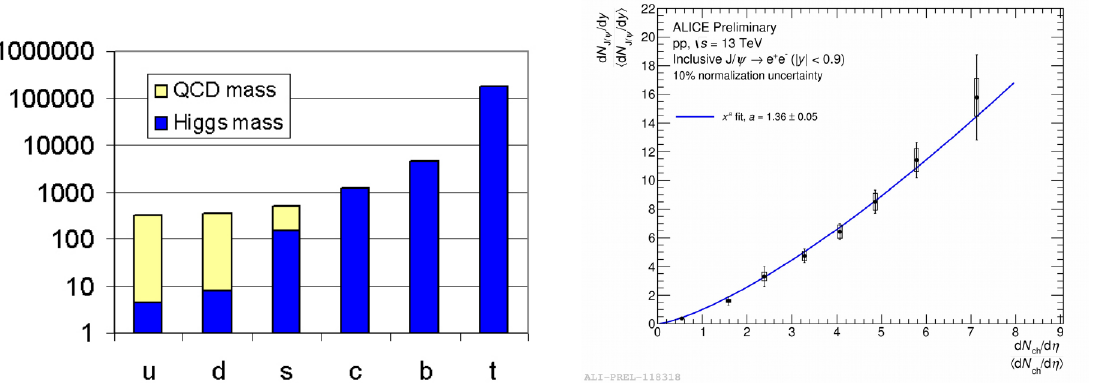
Figure 6. Left : Masses of the six quark flavors. The masses generated by electroweak symmetry breaking (current quark masses) are shown in blue; the additional masses of the light quark flavors generated by spontaneous chiral symmetry breaking in QCD (constituent quark masses) are shown in yellow [23]. Right : Relative J / ψ production (ordinate) yields as a function of the relative number of charged particles per unit of rapidity (abcissa). The blue line corresponds to a fit of a power law function to the data